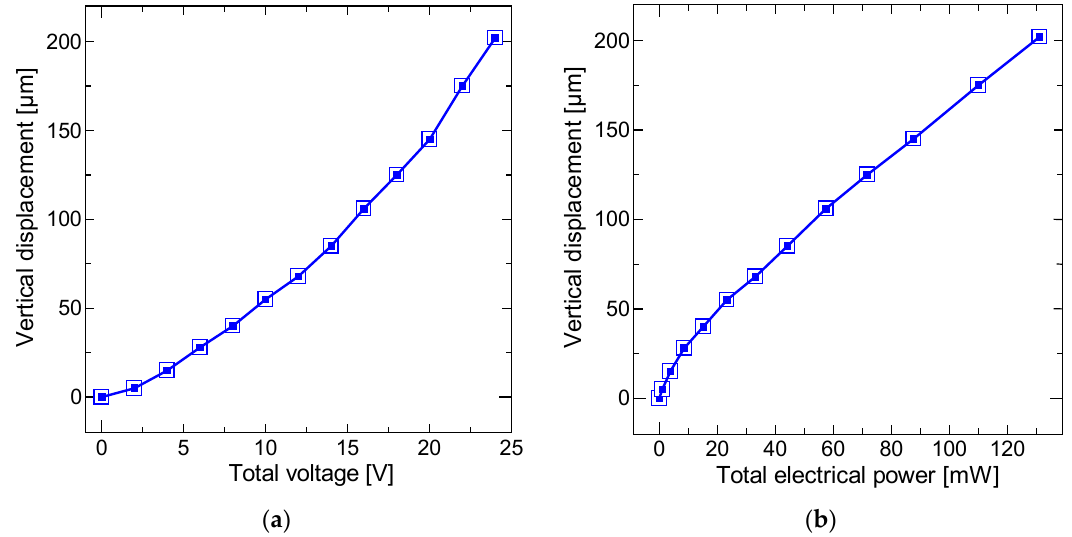
Figure 8. Static response of electrothermal kirigami scanner when the voltage was applied to eight NiCr/SiN bimorphs. The vertical displacement was precisely measured by microscope focusing of a selected point on the platform: ( a ) vertical displacement versus total applied voltage, and ( b ) vertical displacement versus total electrical power.